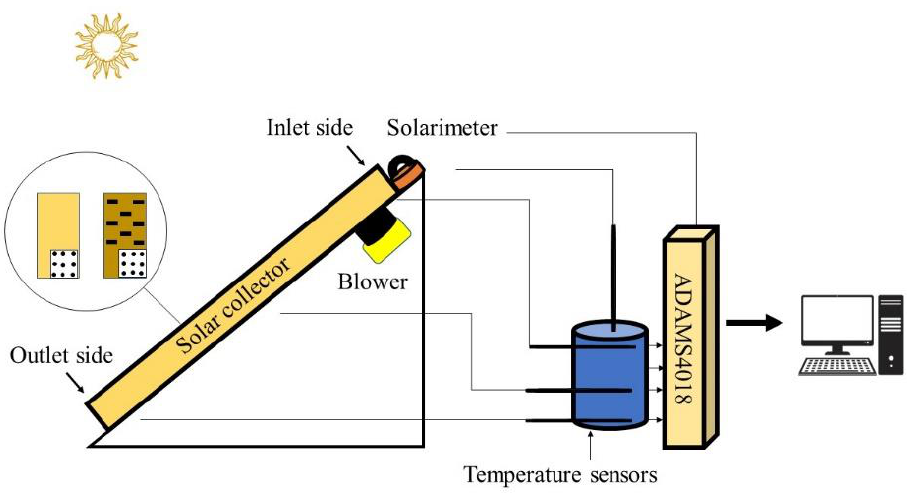
Figure 1. Schematic diagram of the experimental unit.